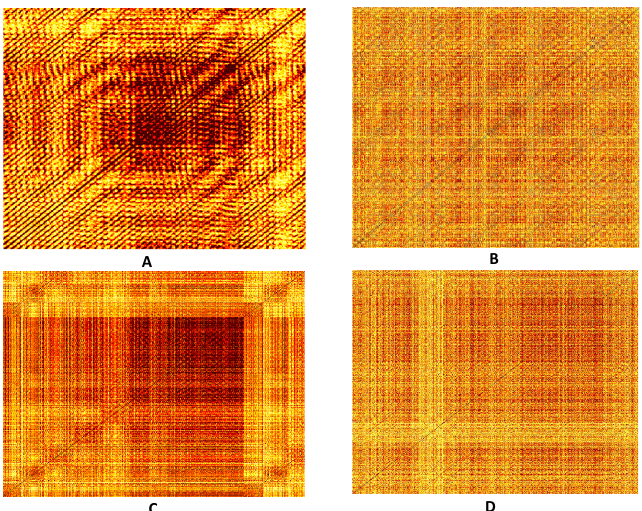
Figure 6. Color recurrence plots generated by vibration signals of a ball bearing. Part ( A ) shows the Color recurrence plot produced by a normal bearing without a fault. Parts ( B – D ) show recurrent plots generated by the bearing with the ball fault, the inner race fault, and the outer race fault